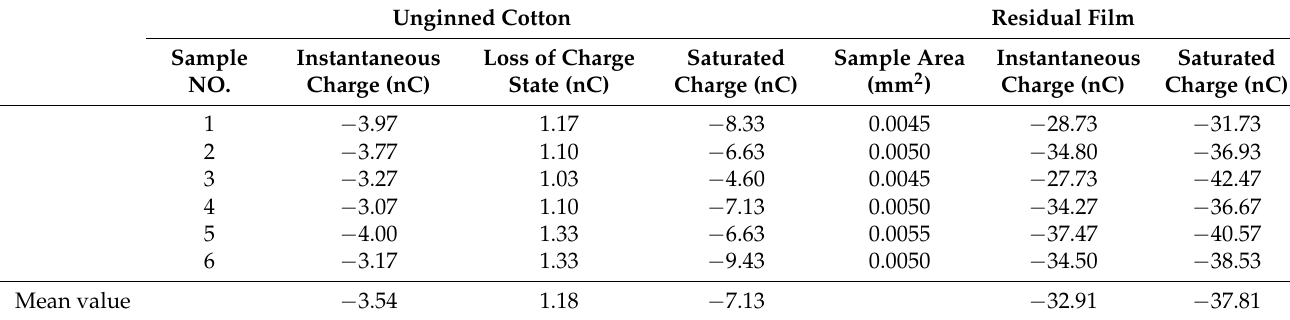
Table 2. Unginned cotton and residual film charge test